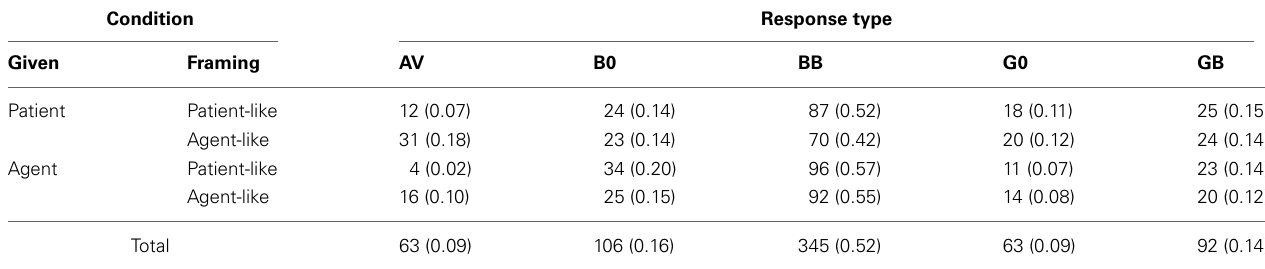
Table 6 | C ross-tabulation results , giving raw counts of responses (AV, active-voice; B0, be-passive without by-phrase; BB, be-passive with by-phrase; G0, get-passive without by-phrase; GB, get-passive with by-phrase) for the two levels per factor (Information Status and Patient